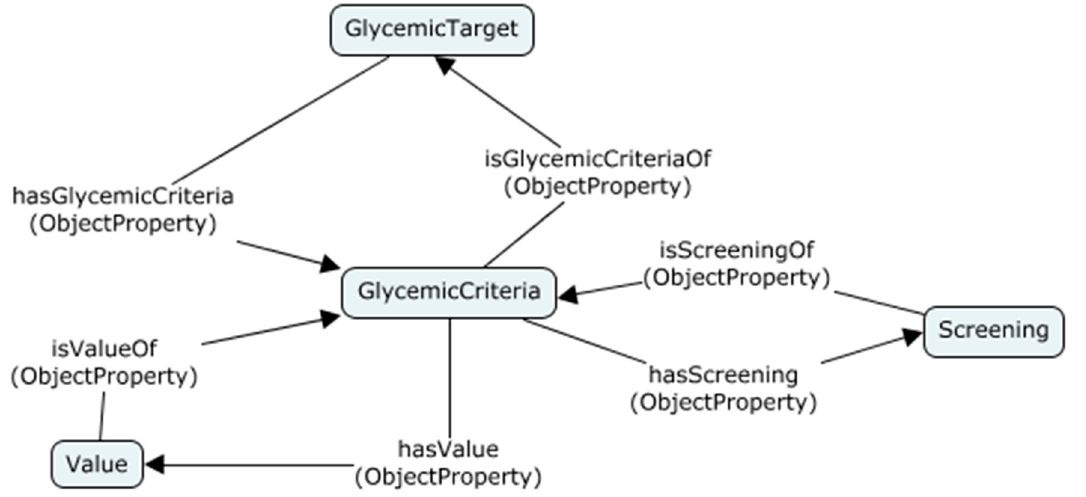
Figure 6. Applying n-ary design pattern 2 . Figure 7 shows the ontology structure to represent knowledge for motivation scenario 1. The management plan of diabetes management can be divided into three subgroups, such as glycemic control, diet plan, and exercise schedule. All three subgroups have different properties and common properties. Therefore, the relationship between the management plan and subgroups forms the hierarchical structure which is the relationship between the main concept and sub-concepts. The sub concepts acquire all the data and object properties of the main concept (super-concept). The main concept includes the common data and object properties, while the sub-concept includes specific data and object properties. If a database is used to represent the hierarchical structure, first we need to design an extended entity-relationship diagram that is very complex to design. Ontology provides